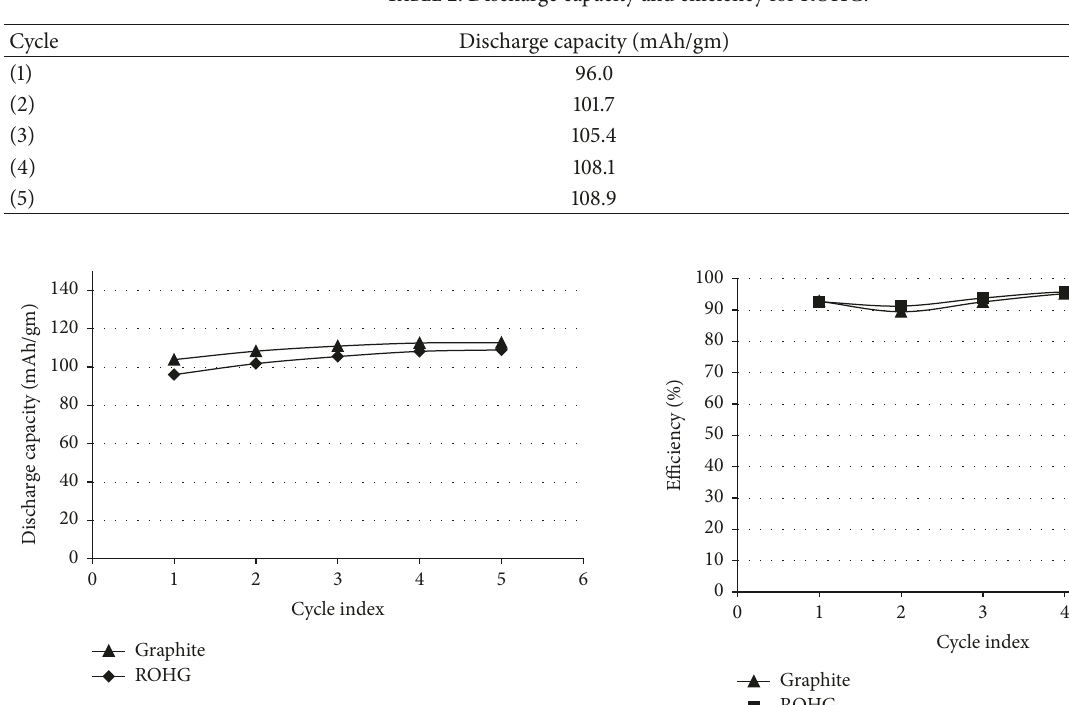
Table 2: Discharge capacity and efficiency for ROHG.